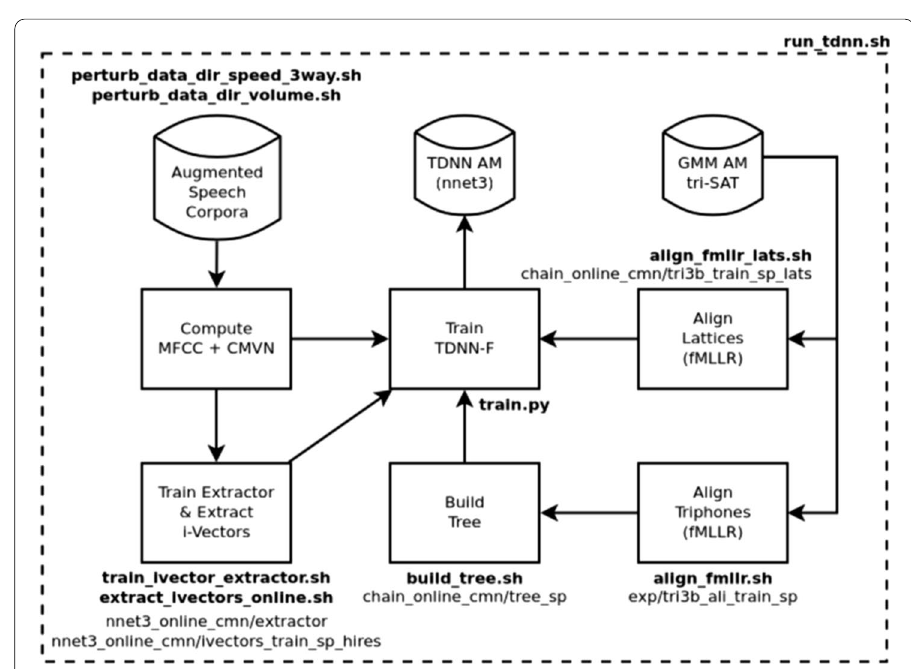
Fig. 3 Stages for training the neural network (TDNN-F) following Kaldi’s Mini-librispeech recipe. High-resolution, cepstral-normalized MFCCs (40 features instead of 13) are extracted from a speed/volume augmented corpora, as are the 100-dimensional i-vector features; to be used as input to the DNN. Training labels, on the other hand, are provided by a GMM tri-SAT acoustic model. At the top or bottom of each block, there is a reference for a script (boldface) and the directory where resources created by that script are usually stored (normal text). For details on the training pipeline of the tri-SAT and all previous GMM-based acoustic models, the reader is referred to Fig.